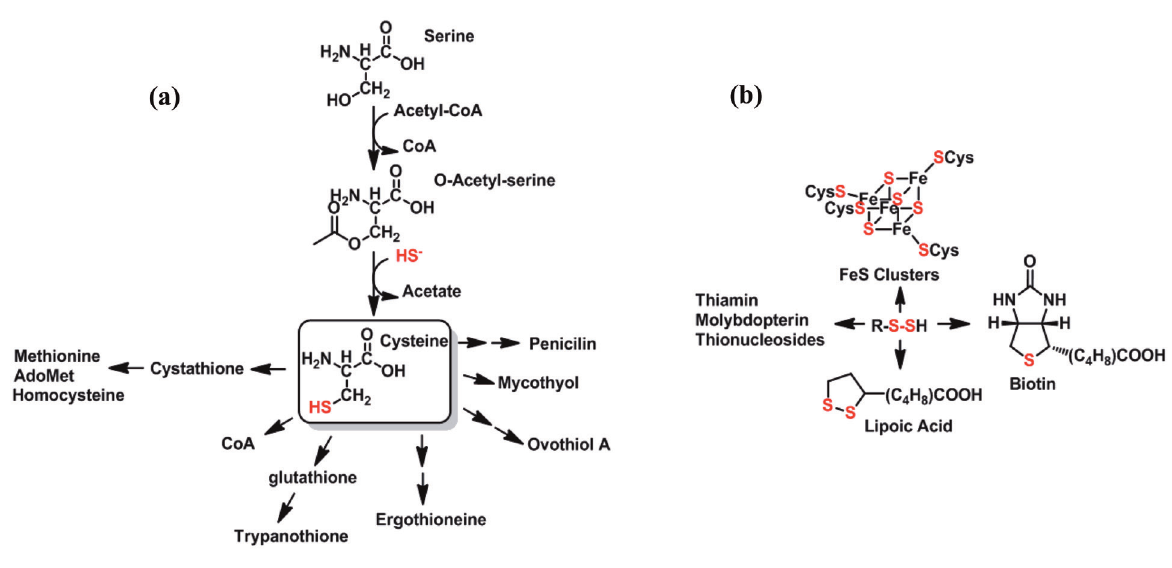
Figure 1 - Sulfur pathway in the metabolism of several